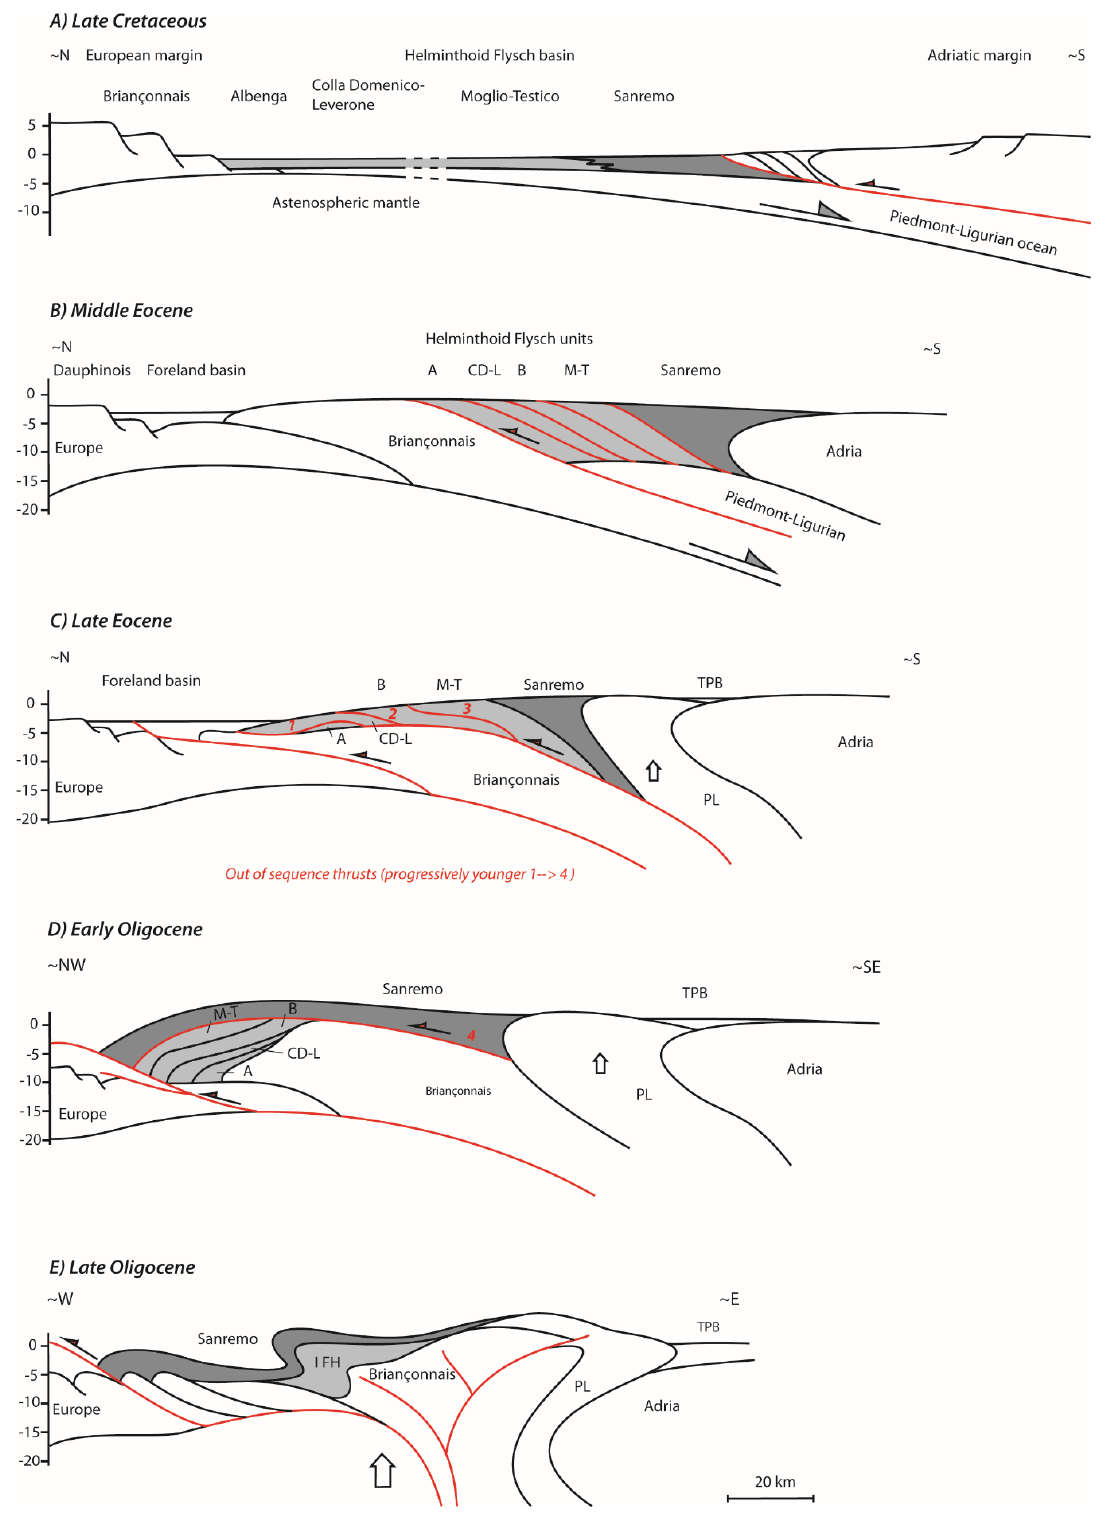
Figure 10. Geodynamic sketch showing the kinematic path of the Helminthoid Flysch nappes within the evolution of the Ligurian orogen between the Cretaceous – Oligocene times, after [8]. TPB: Tertiary Piedmont Basin.